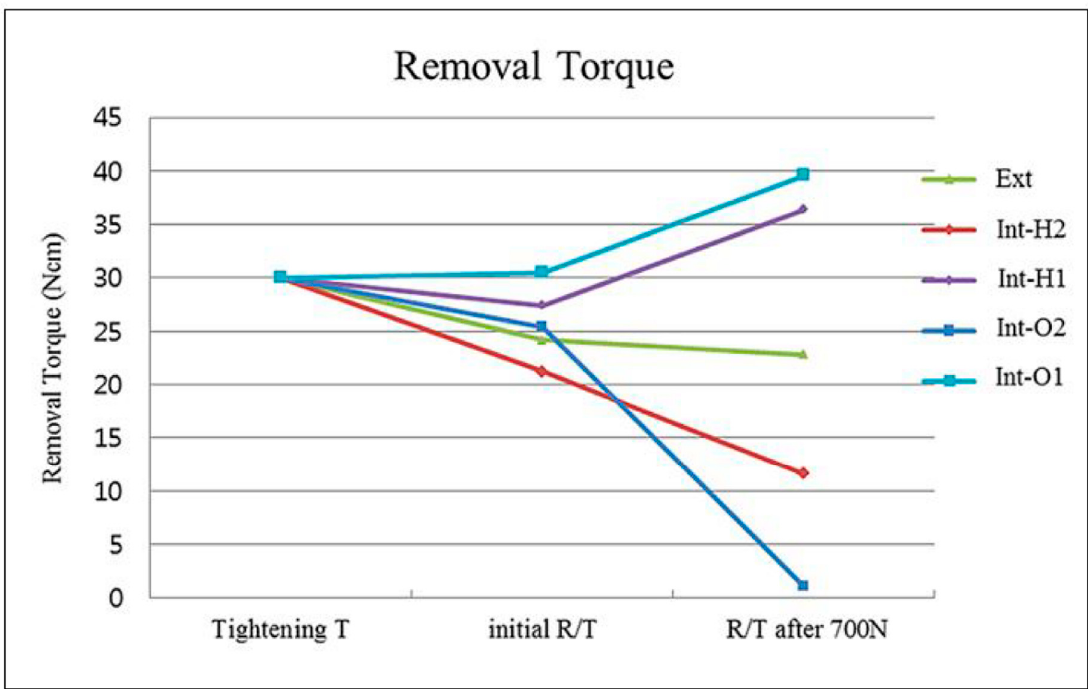
Figure 5. Removal torque (Ncm) after 700 N static loading.